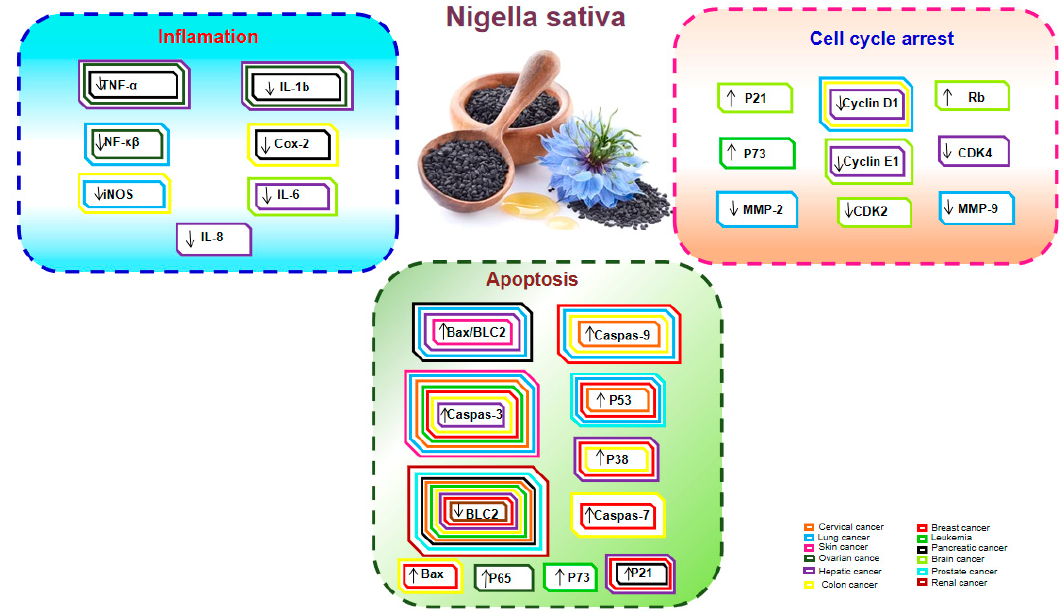
Figure 1. A brief overview of several cellular signaling pathways influenced by N. sativa and its main components through molecular targets in various types of cancer.